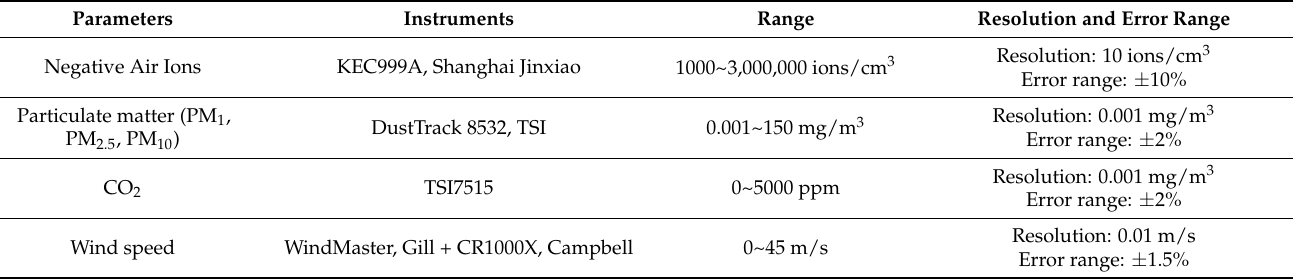
Table 2. Air quality parameter and instrument.